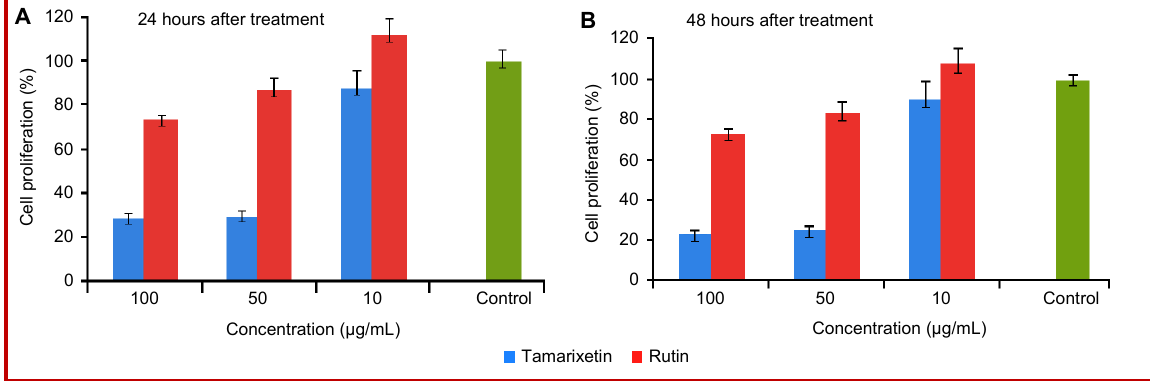
Figure 4: Cell proliferation (%) for 24 and 48 hours after the sample treatment at tested